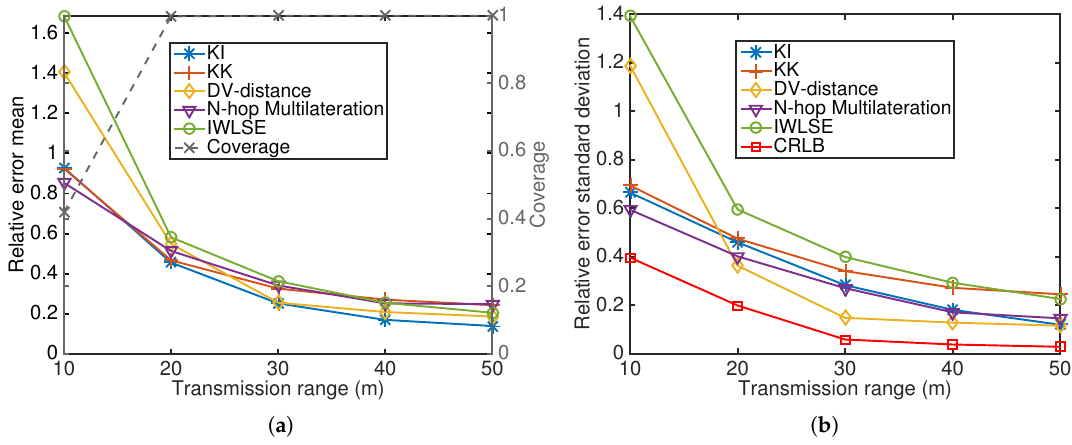
Figure 11. ( a ) Average estimation error and coverage, ( b ) SD as a result of changing the transmission range.